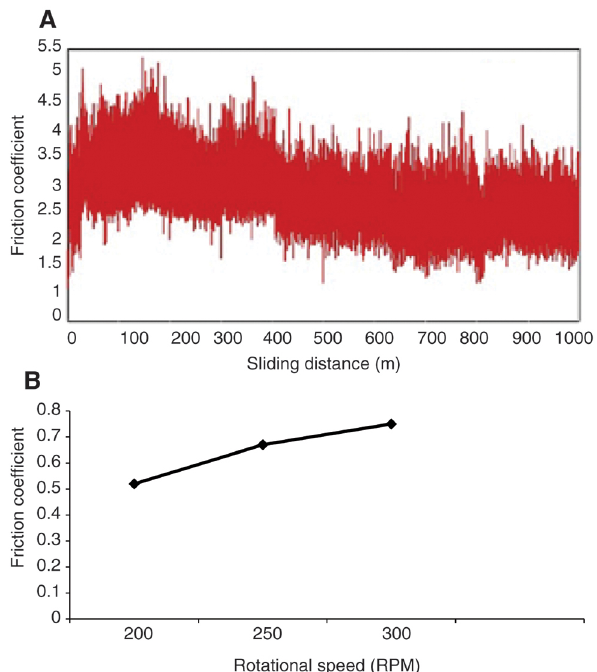
Figure 7: Coefficient of friction variation in (A) NiTi vs. sliding distance; (B) NiTi vs. rotation speed.